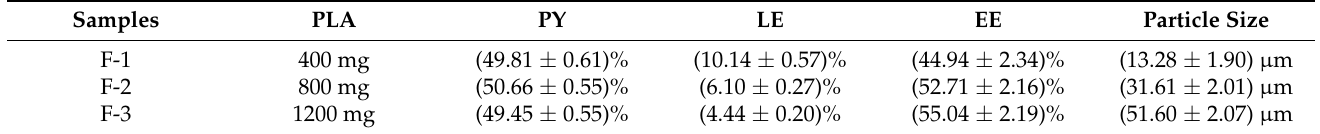
Table 3. The influence of the amount of PLA used ( n = 3, mean ± SD).